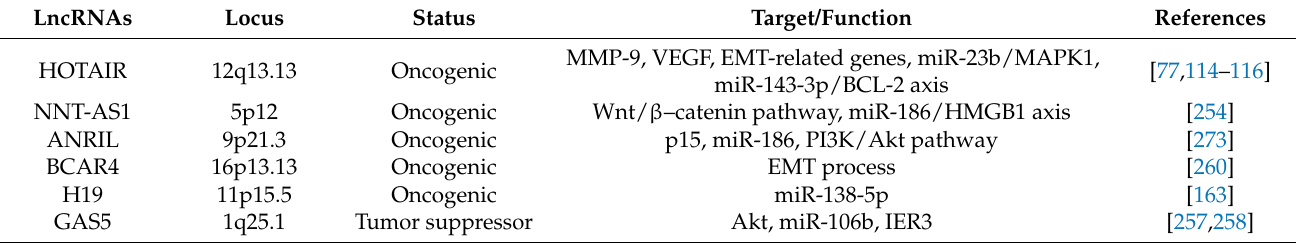
Table 3. LncRNAs involved in proliferation, invasion, apoptosis, migration, metastasis, and drug resistance in cervical